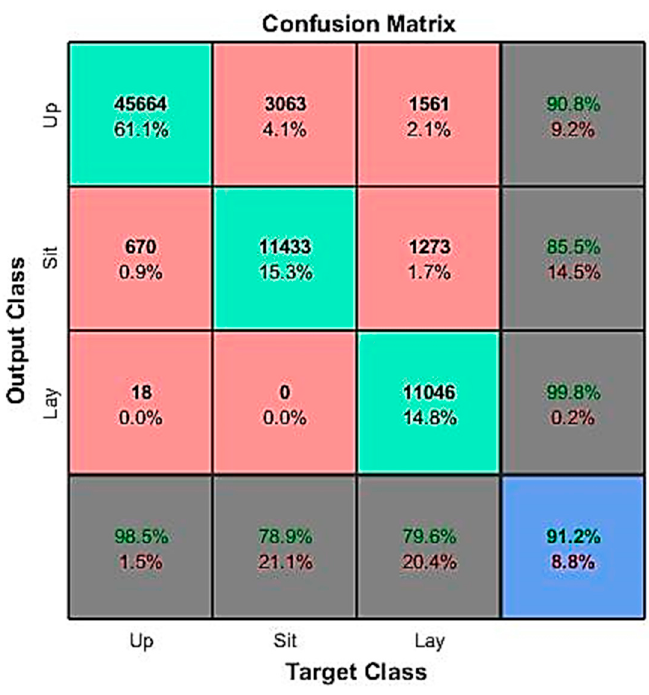
Figure 9. A confusion matrix example.